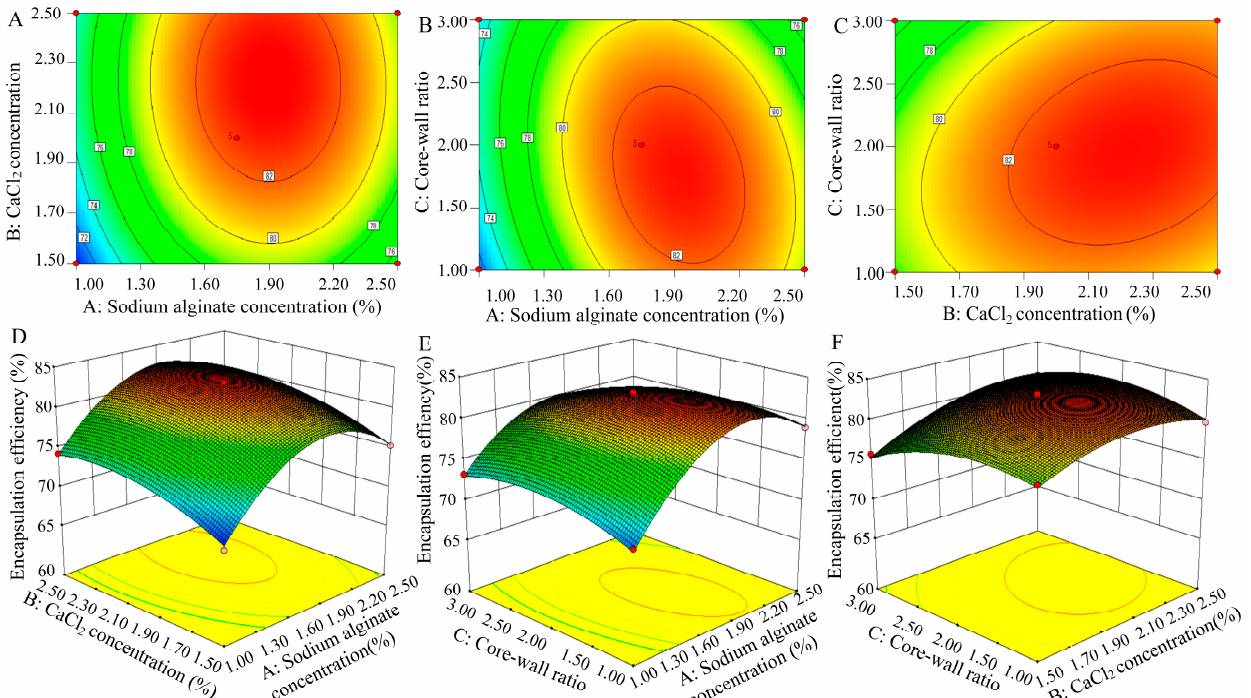
Figure 3. Two-dimensional contour plot and response surface plot for encapsulation efficiency